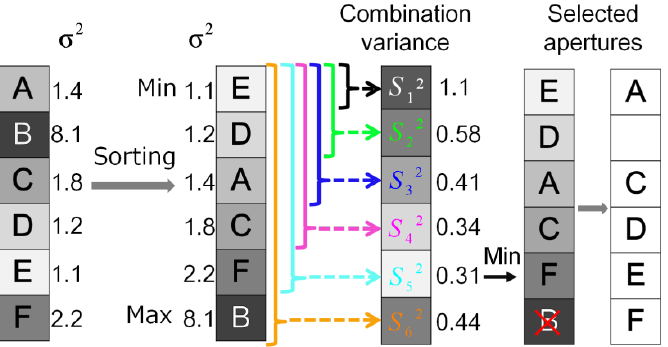
Figure 4. Procedure of aperture selection for one